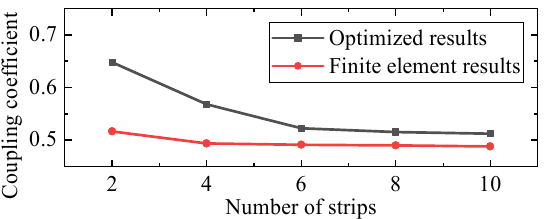
Figure 22. Comparison between the optimized and finite element results. Table 6. Results of the finite element analyses.